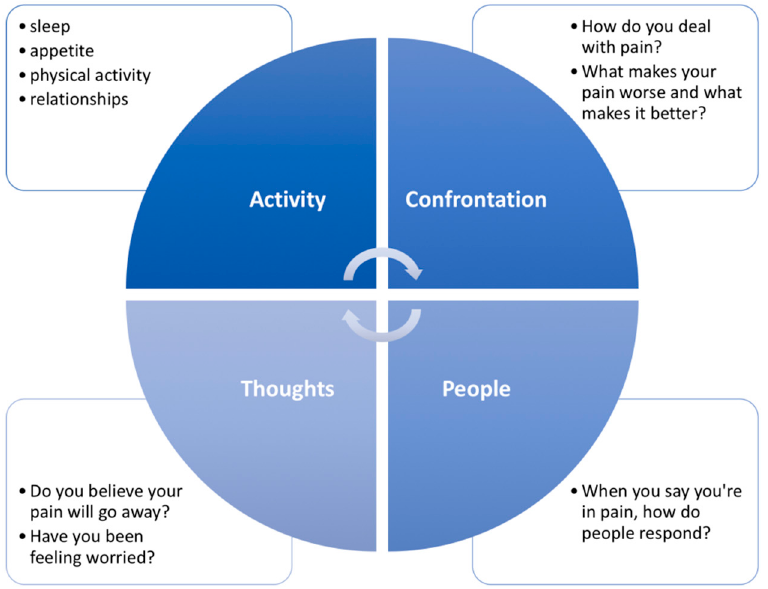
Figure 4. Brief screening model of the psychosocial aspects of the individual with pain based on the ACT-UP (activity, coping, think, upset, people's responses) model [63].